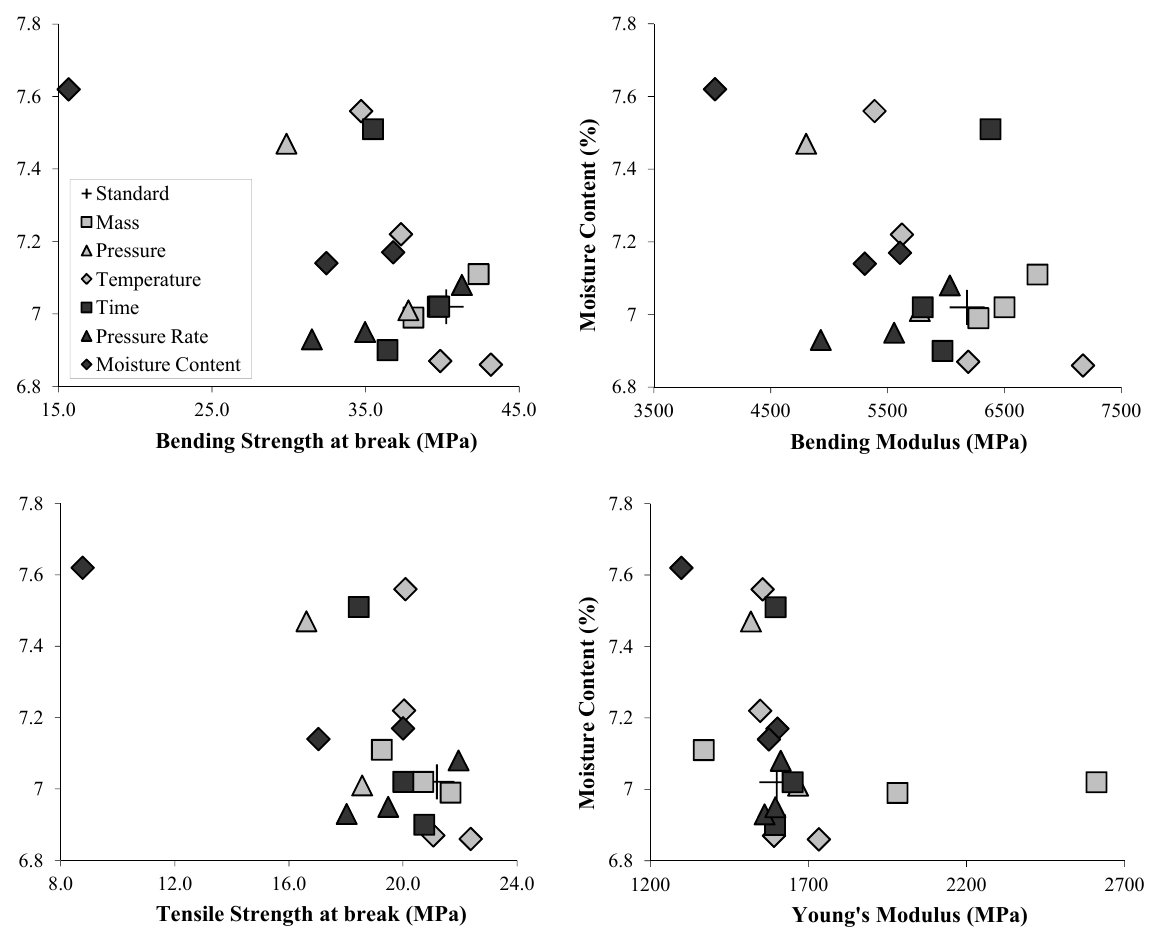
Figure 10. Moisture content of compression-molded specimens at 60% RH expressed against Tensile and Bending Strength at break, Bending Modulus and Young’s